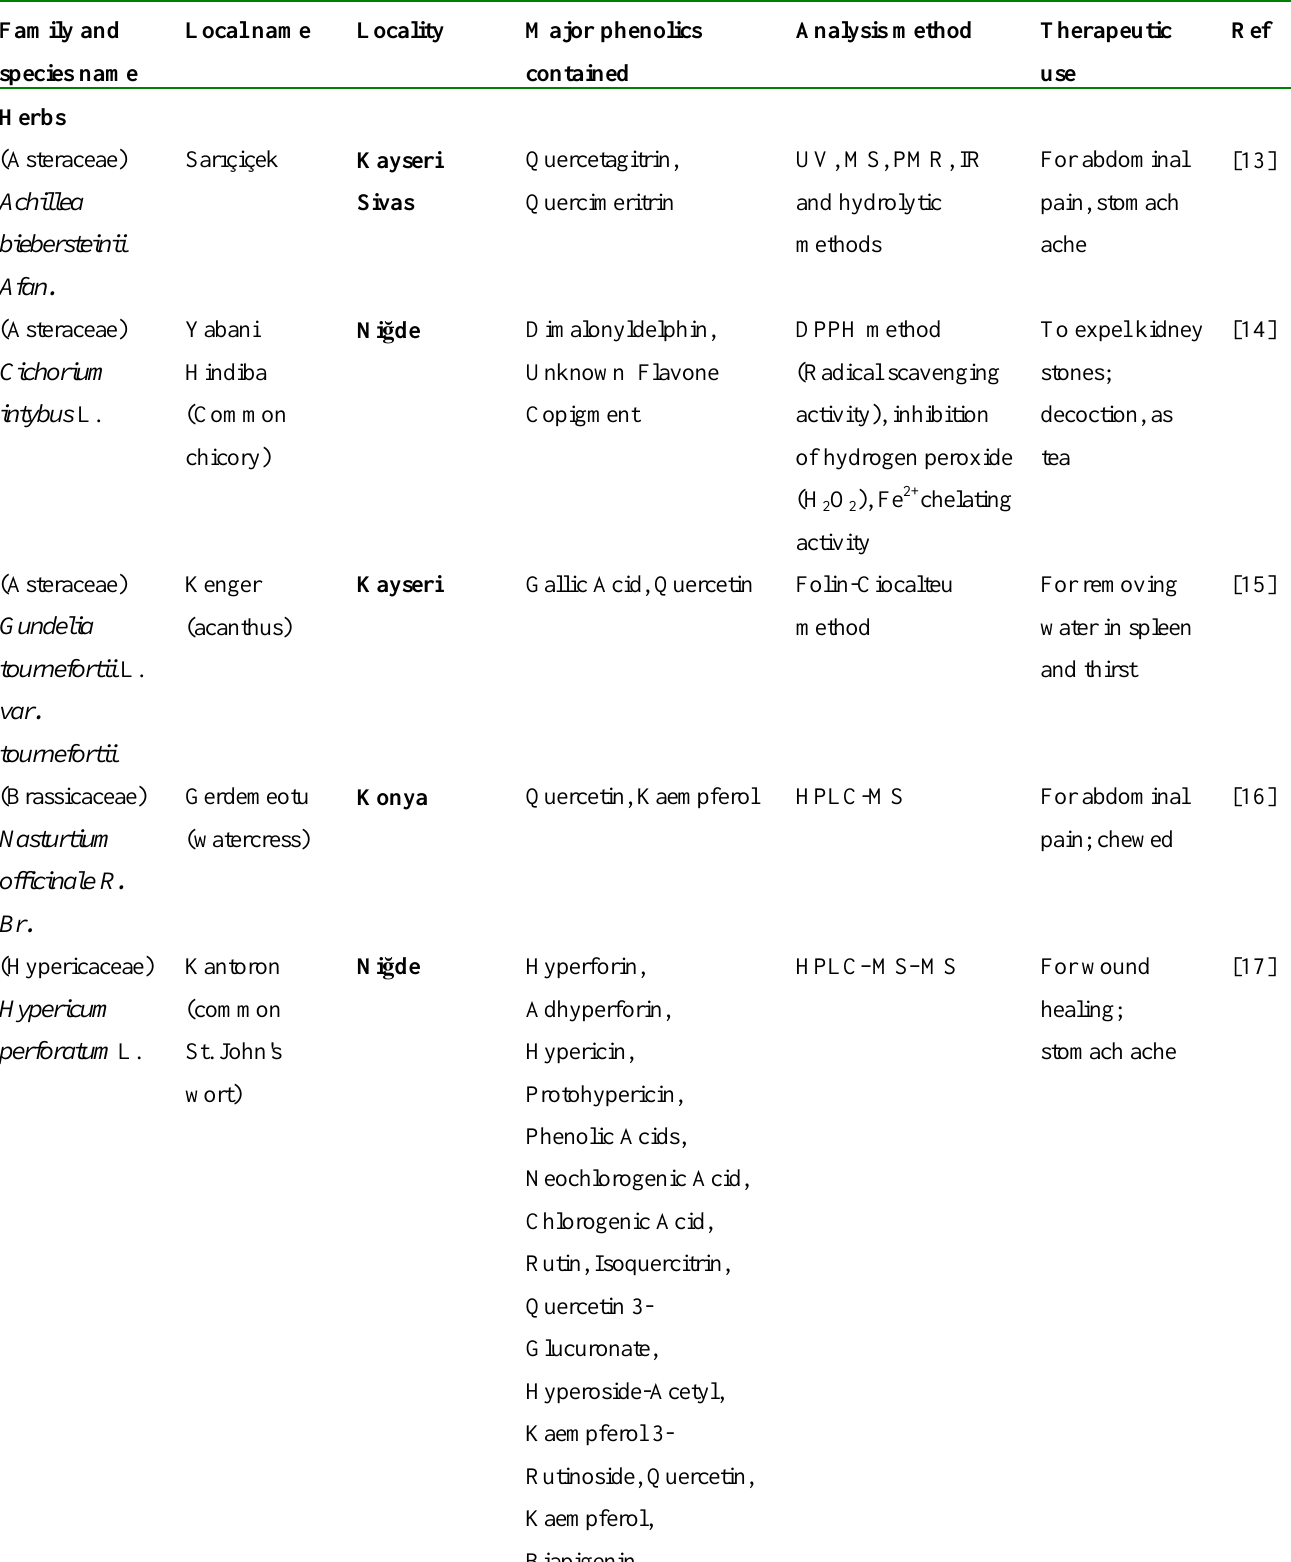
Table 1. A number of selected food plants harvested in different geographical locations of Turkey, with their major speciation of antioxidant phenolics and the method of